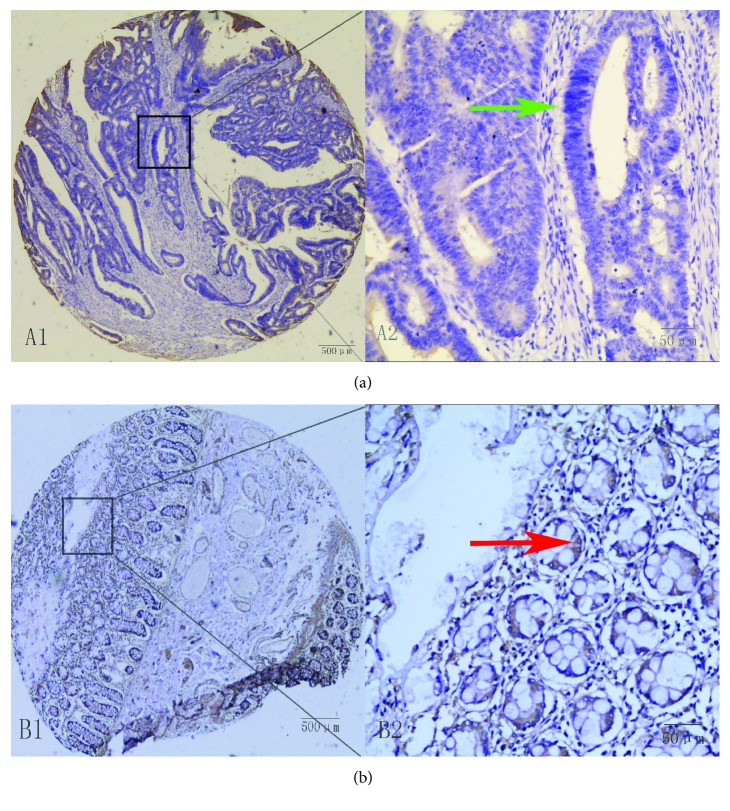
Immunohistochemical staining was carried out on paraffin-embedded 4 μm sections, and representative patterns of RARβ protein expression in colorectal cancer (a) and peritumoral tissue (b) are shown. In colorectal cancer tissues, no expression was observed (A1 and A2). In adjacent normal colorectal tissues, high RARβ expression was observed (B1 and B2). A1 and B1: original magnification ×40 (bar = 500 μm): A2 and B2: ×400 (bar = 50 μm).